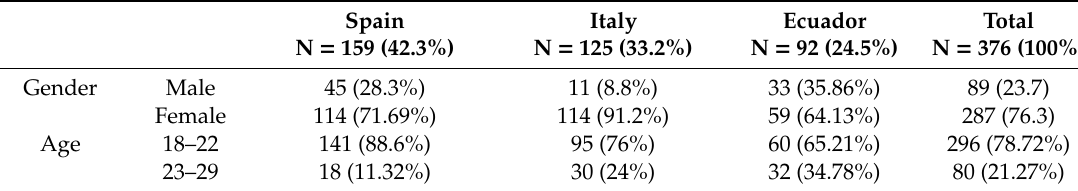
Table 1. Description of the sample according to age, gender, and